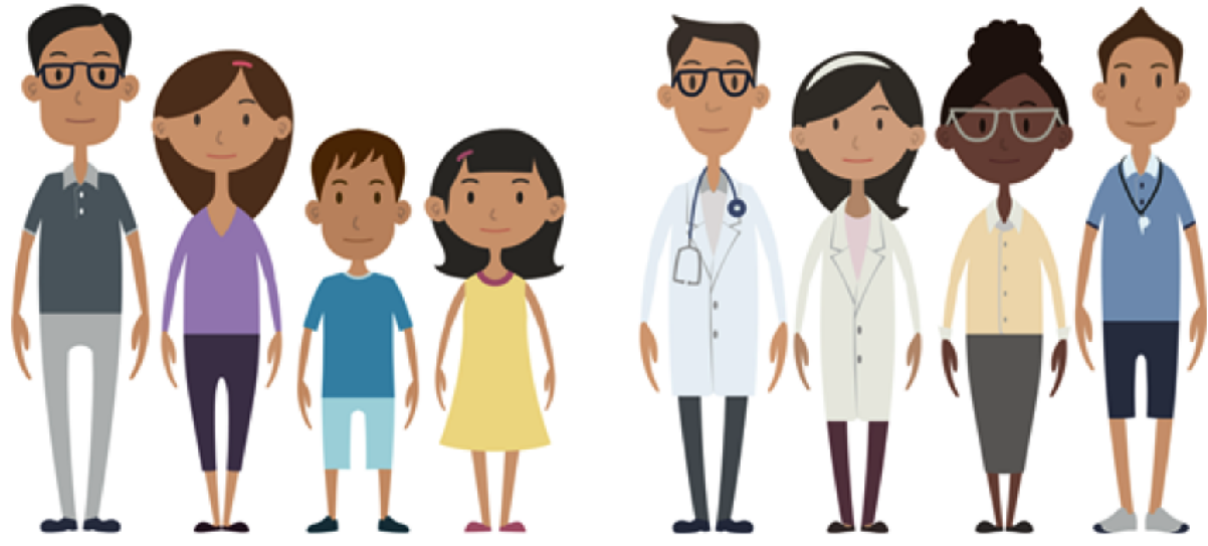
Figure 4. Cast of